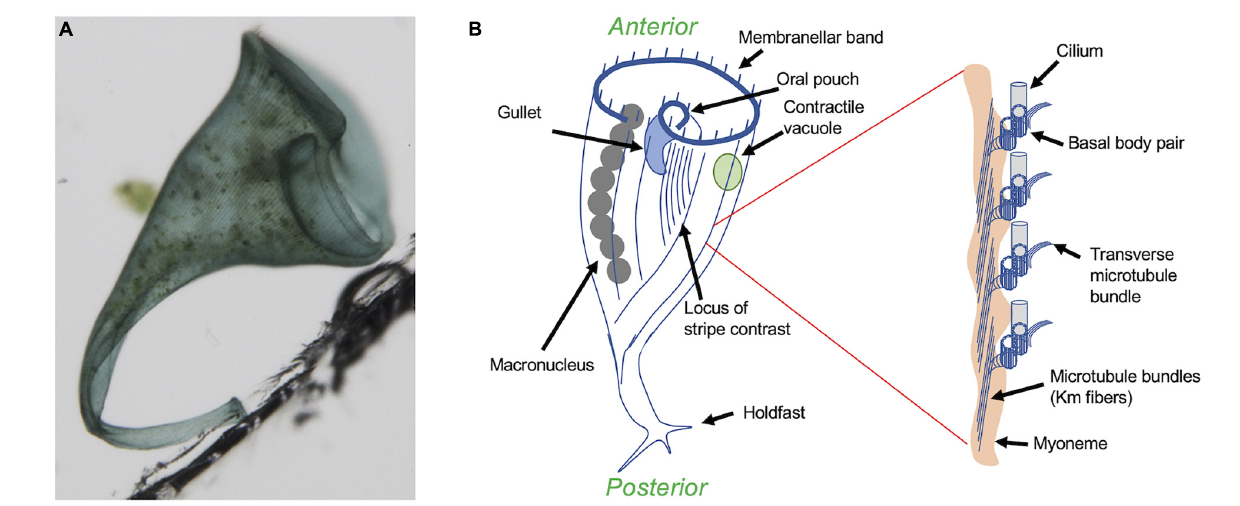
FIGURE 1 | Overview of Stentor coeruleus . (A) Micrograph of a single Stentor cell, attached to the wall of a plastic chamber via its holdfast. (B) Anatomy of Stentor . The oral apparatus (OA) is located at the anterior end of the cell and consists of a membranellar band of cilia, an oral pouch where food is temporarily captured, and a gullet where food is ingested. Inset shows expanded view of the region circled in red, illustrating the ultrastructural organization of the ciliary rows. Each row contains not only pairs of basal bodies, one of which nucleates a cilium, but also a parallel array of microtubule bundles known as Km fibers (Huang and Pitelka, 1973) and, underneath the microtubules, a contractile fiber bundle known as a myoneme, which is composed of centrin-like EF hand calcium binding proteins (Maloney et al., 2005). An additional set of microtubule bundles, known as transverse microtubules, emerge from each basal body pair and extend perpendicularly to the Km fibers toward the adjacent ciliary rows. The spaces in between these rows are filled with blue pigment, giving rise to the blue color seen in (A) . The spacing between the ciliary rows shows a circumferential variation, such that the spacing between the rows, and hence the width of the intervening blue stripes as well as the lengths of the transverse microtubule bundles, starts out large at one side of the cell and then gradually decreases as one moves around the circumference, until eventually the narrowest stripes (mostly closely spaced ciliary rows) about the widest stripes (mostly widely separated ciliary rows). This region is known as the locus of stripe contrast, and represents a key site for regeneration of oral